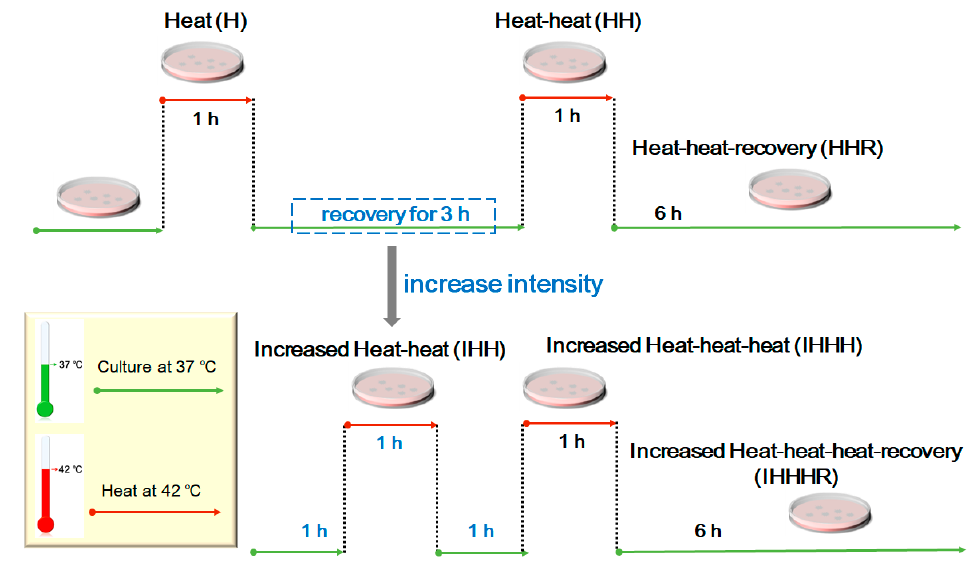
Figure 1. Schematic representation of heat-shock experimental design.